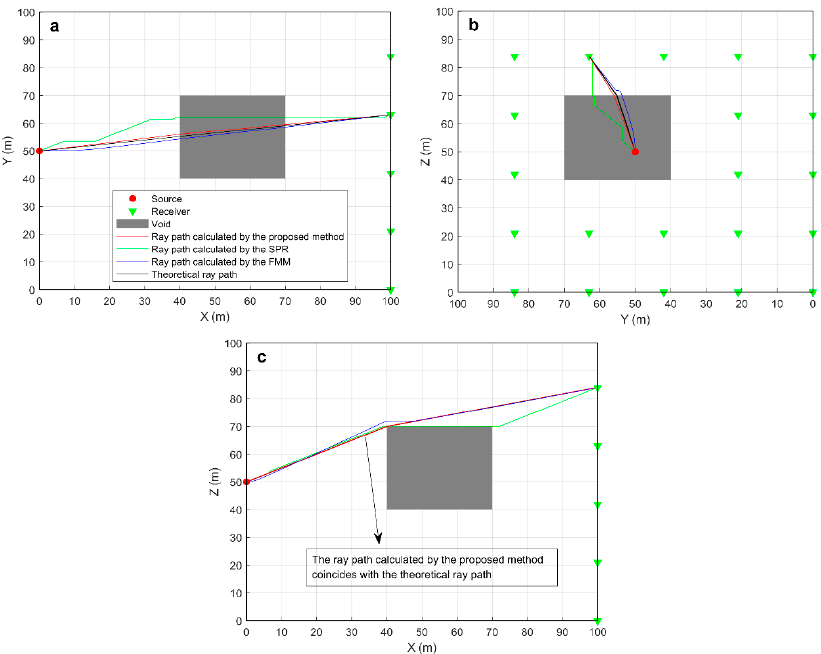
Figure 10. The ray path of the receiver R20 is calculated by the proposed method, FMM, and SPR. ( a ) The view on XY plane, ( b ) the view on YZ plane, and ( c ) the view on XZ plane. Table 1. Receiver coordinates and travel time calculated using the proposed method, FMM, and